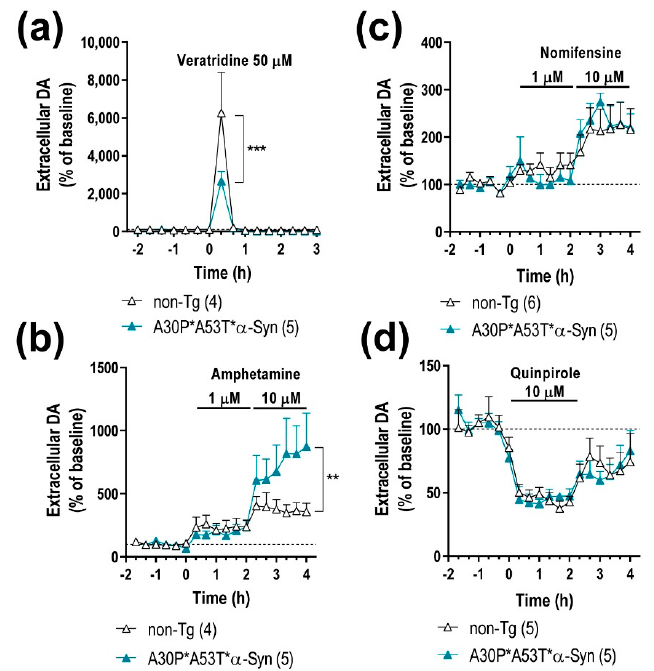
Figure 4. A30P*A53T* α -Syn overexpression in TH + neurons alters DA neurotransmission in the nigrostriatal pathway. ( a ) Local veratridine infusion (depolarizing agent; 50 µ M) significantly increased DA release in the caudate putamen (CPu) of both mouse phenotypes. However, this effect was significant smaller in A30P*A53T* α -Syn mice than in non-Tg mice. ( b ) Direct application of amphetamine (DA releaser and DAT inhibitor; 1 and 10 µ M) by reverse dialysis induced increases in DA release in the CPu, with the effect being significantly more pronounced in A30P*A53T* α -Syn mice than in non-Tg mice. ( c ) However, local nomifensine infusion (DAT inhibitor; 1 and 10 µ M) dose-dependently increased the extracellular DA concentration in CPu, with this effect com- parable being in both phenotypes. ( d ) Local activation of DA D2 receptors with quinpirole (DA D2 agonist, 10 µM) similarly decreased striatal DA release in A30P*A53T* α -Syn and non-Tg mice. Data are expressed as the mean ± SEM, n = 4–6 mice/group as indicated in the parenthesis. Two- way ANOVA and Tukey’s multiple comparisons test, ** p < 0.01, *** p < 0.001 compared with non- Tg mice.